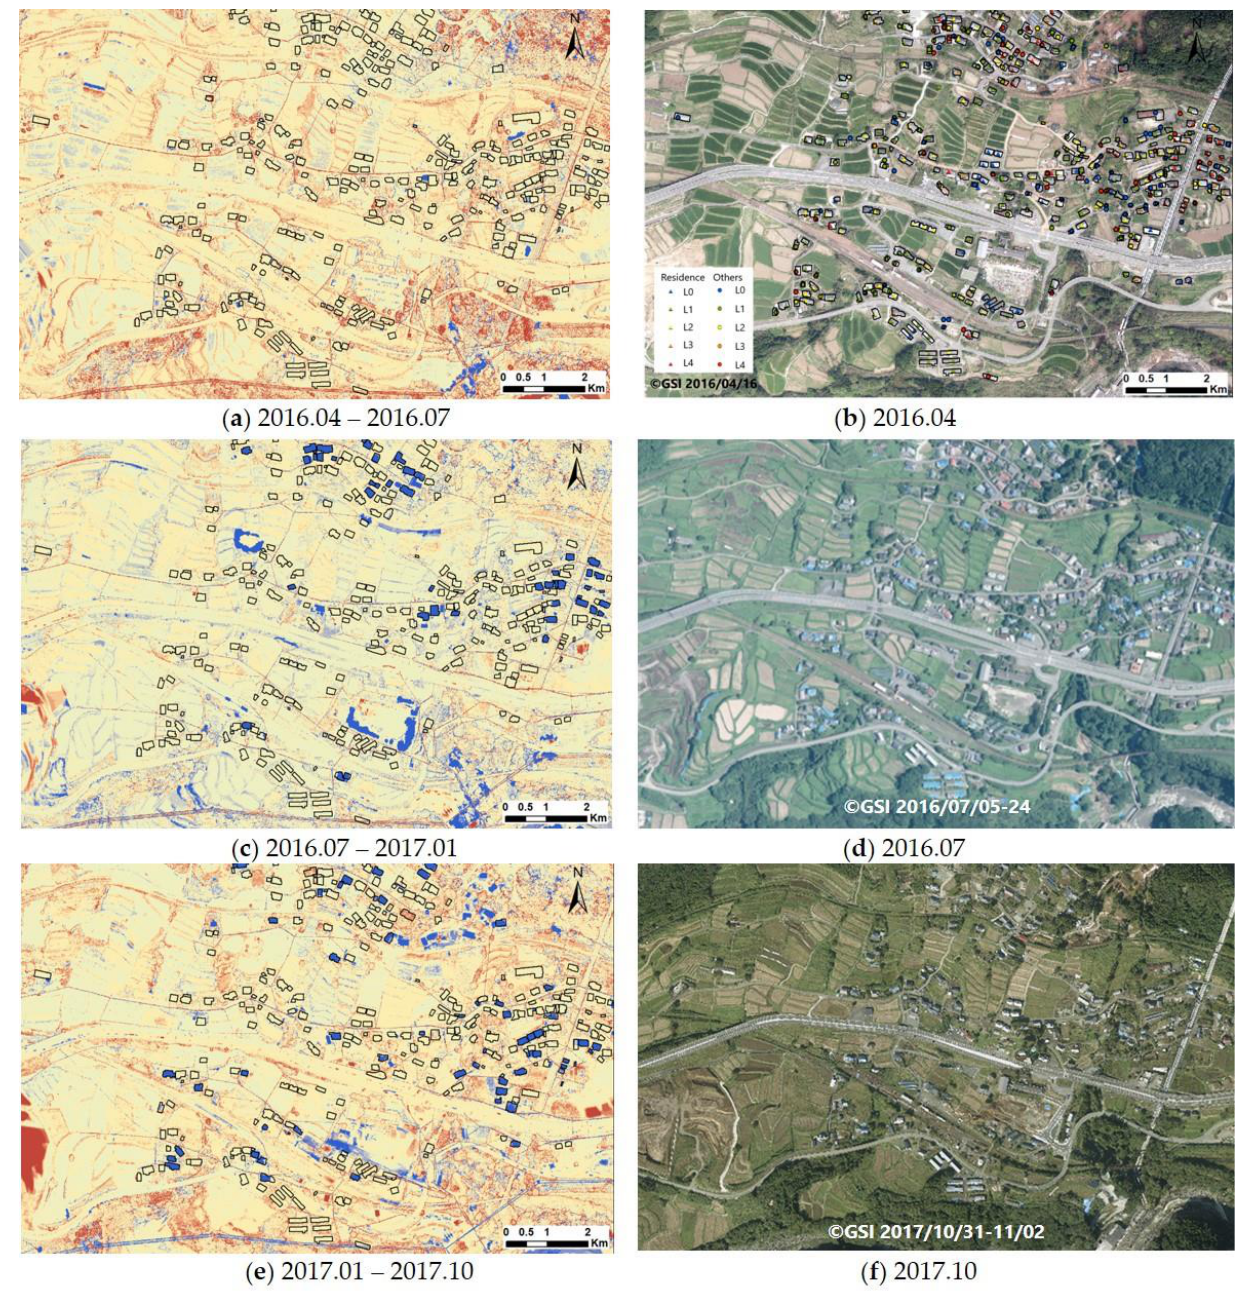
Figure 16. DSM difference for Tateno district in the three periods after the earthquake ( a , c , e ), and the optical images (the close-ups of Figure 4) on three corresponding dates ( b , d , f ). The color chart of the DSM differences is the same as that in Figure 8. In the aerial photo ( b ), taken by GSI on 2016/04/16, building footprints and damage levels are also shown in the same manner as in Figure 10 for